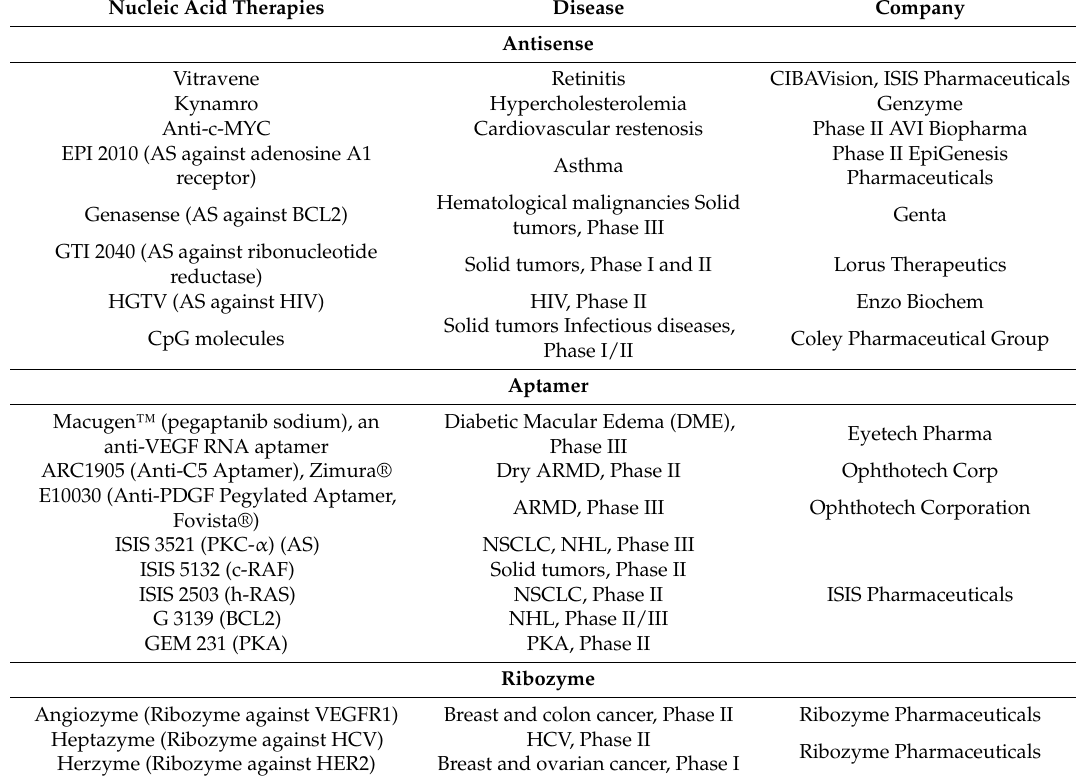
Table 1. List of nucleic acid therapies in clinical trials